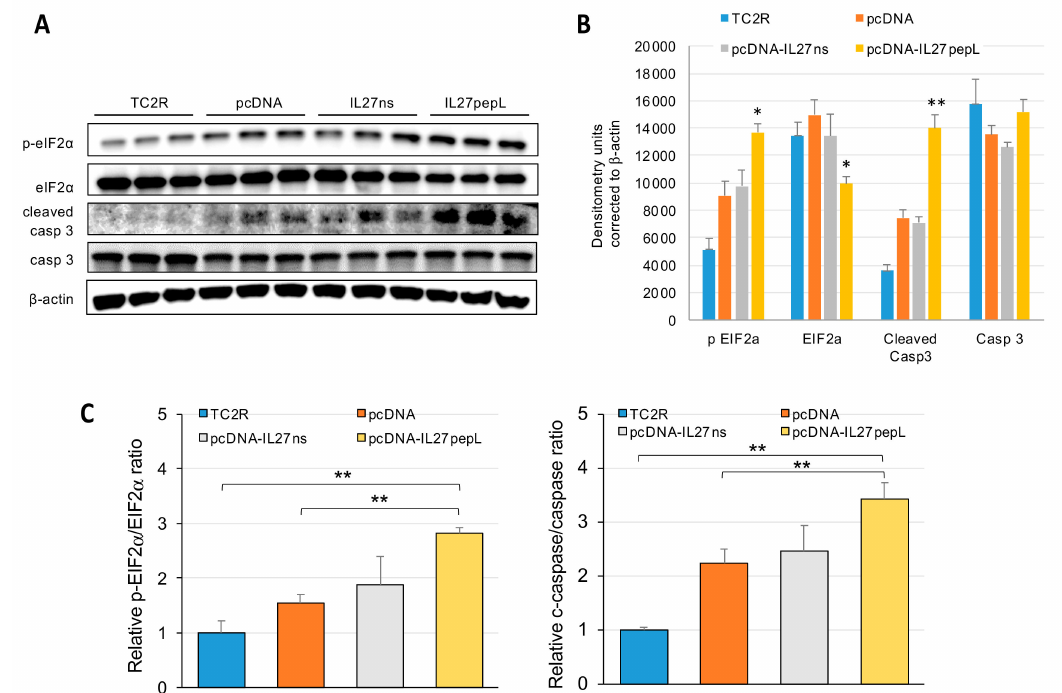
Figure 8. Western blots assessed protein and functional status relating to the EIF2 pathway. The eIF2 pathway protein alterations, such as levels of eIF2 α and its phosphorylation status ( A ), as well as functional validation of the eIF2 pathway by levels of caspase-3 and cleaved caspase-3 quantification, were assayed by Western blot. ( B ) Quantification by densitometry of Western blots corrected to α -actin housekeeping gene control. ( C ) Determination of p-eIF2 α / eIF2 α and cleaved caspase-3 (cleaved Casp3) / caspase-3 (Casp3) ratios; * p < 0.05, ** p < 0.01. C, control TC2R cells without any